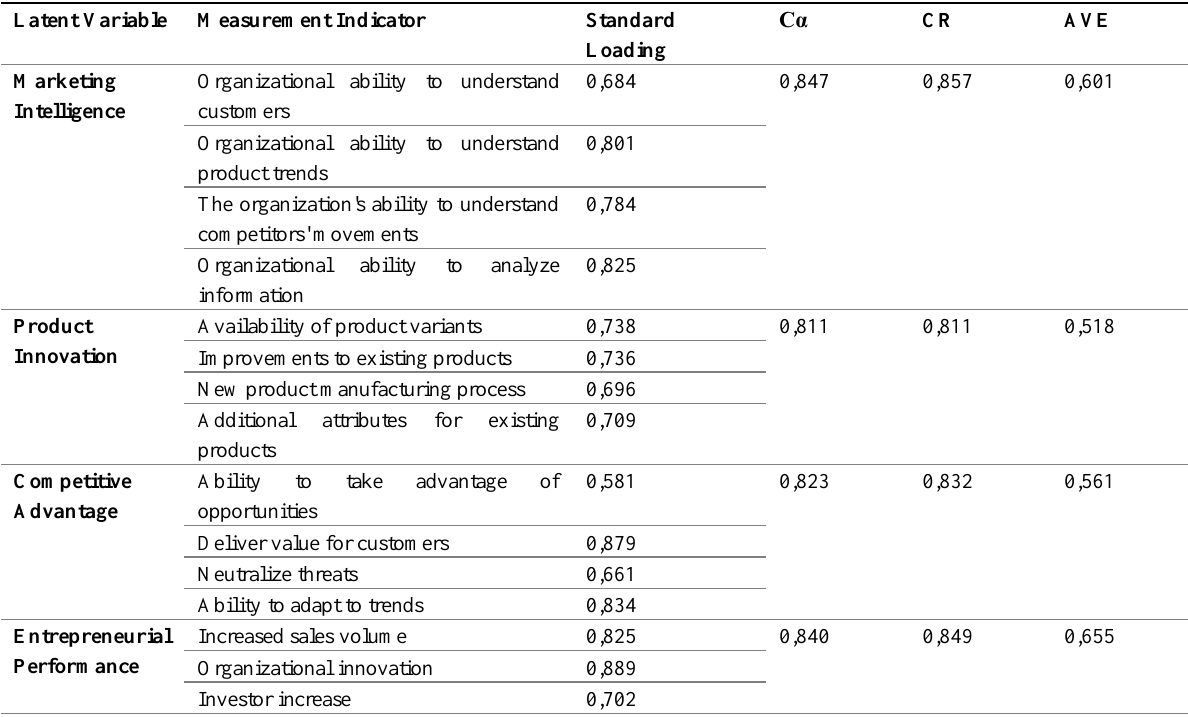
Table 4: Reliability Test and Standardized Loading Estimate